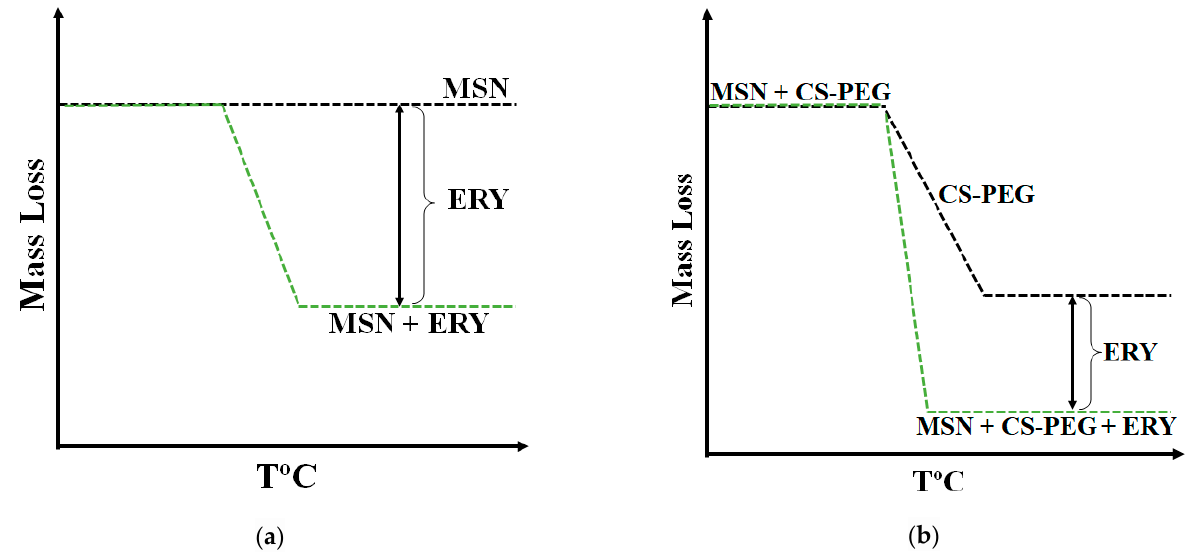
Figure 16. Graphical representation of the calculation ERY amount in ( a ) MSN or ( b ) coated MSN via TGA analysis.